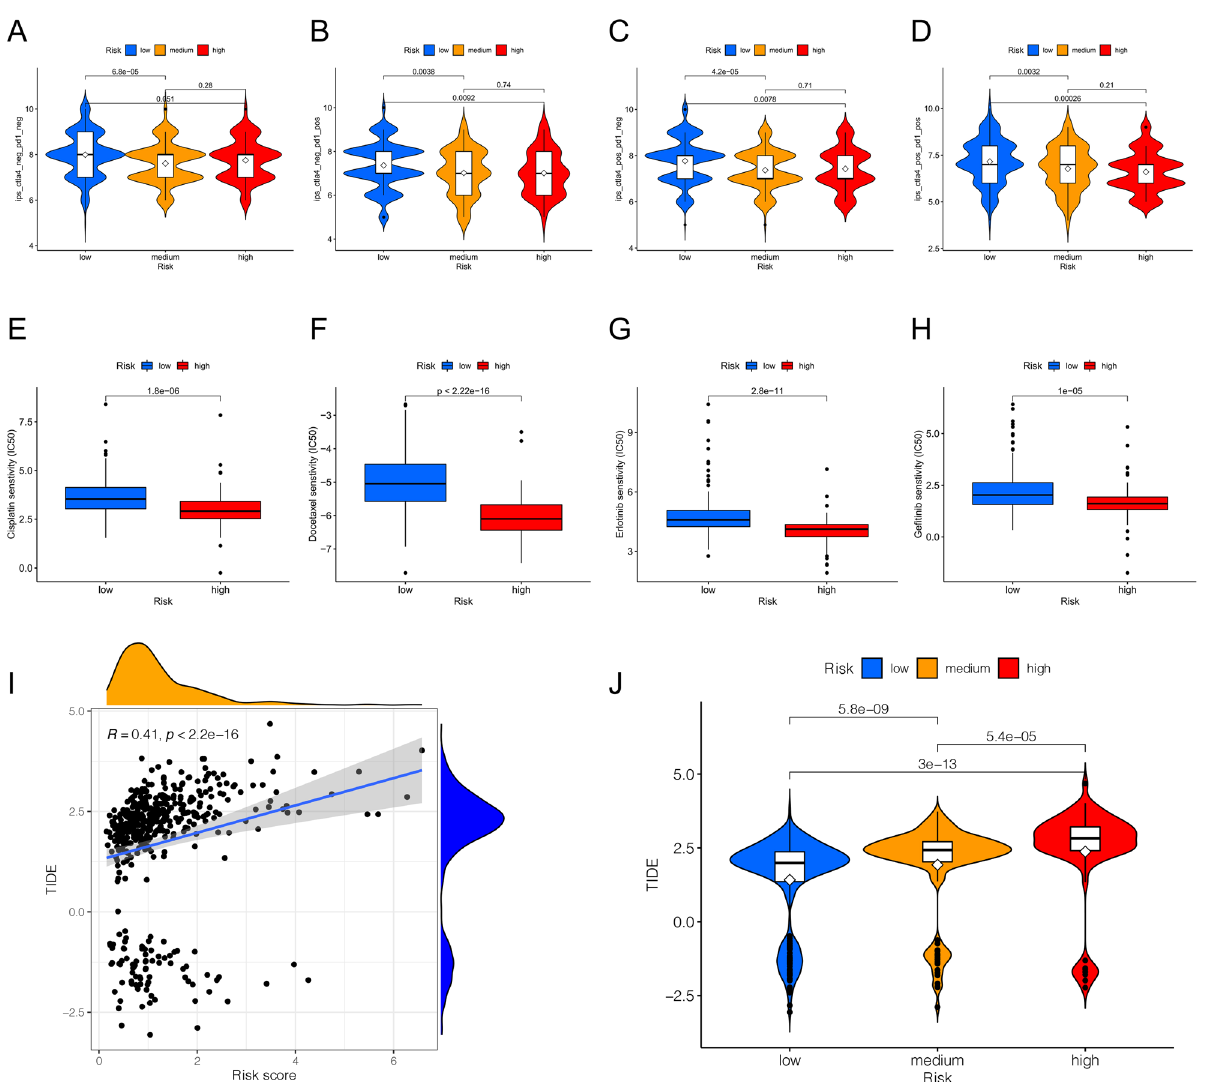
Figure 8. Immunotherapy effect and drug sensitivity analysis using R software. ( A – D ) Differences in IPS among different risk groups in the four situations: negative immunoresponse to both PD-L1/PD-1 inhibitors and CTLA-4 inhibitors ( A ); positive immunoresponse to PD-L1/PD-1 inhibitors ( B ); positive immunoresponse to CTLA-4 inhibitors ( C ); positive immunoresponse to both PD-L1/PD-1 inhibitors and CTLA-4 inhibitors ( D ). ( E – H ) Differences in sensitivity of cisplatin ( E ), docetaxel ( F ), erlotinib ( G ), gefitinib ( H ) between high and low risk groups. ( I ) Spearman analysis between TIDE score and risk score. ( J ) Differences in TIDE score among different risk groups. The hollow diamond patterns in the violin diagram represent the IPS or TIDE score ensemble